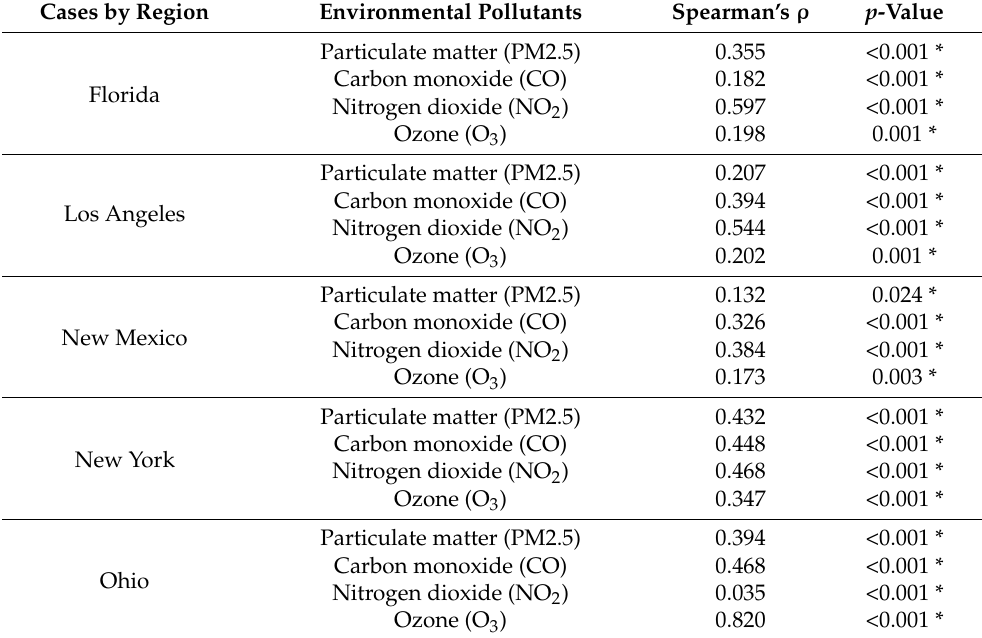
Table 1. Correlation of PM2.5, CO, NO 2 and O 3 with the number of SARS-CoV-2 cases by region.